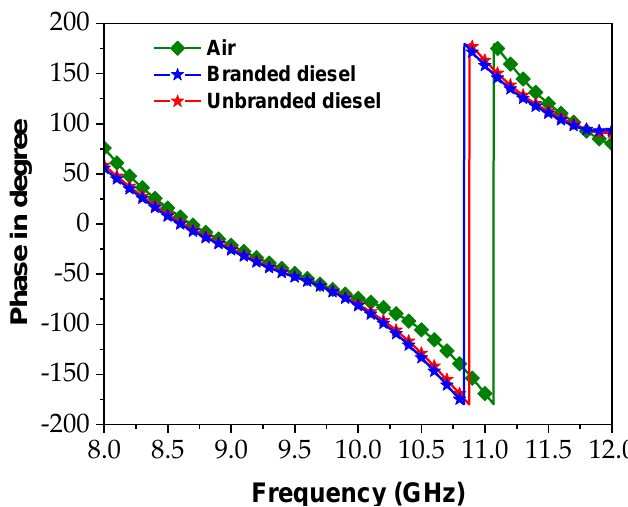
Figure 6. Simulated transmission phase for air, branded diesel, and unbranded diesel.